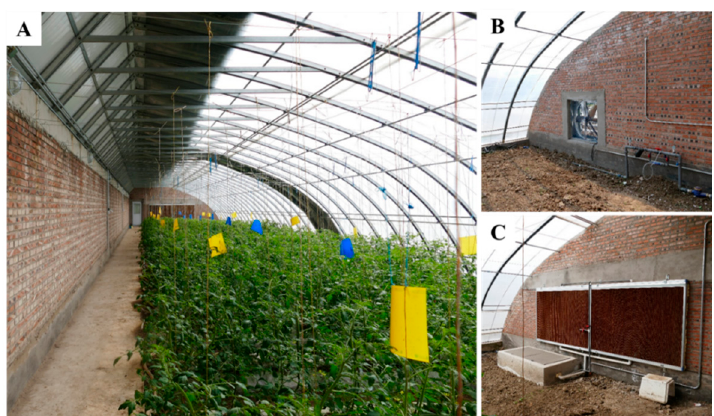
Figure 1. A solar greenhouse and the cooling devices used in the hot summer. ( A ), tomato plants and sticky card traps in a greenhouse; ( B ), cooling fan; ( C ), water curtain.